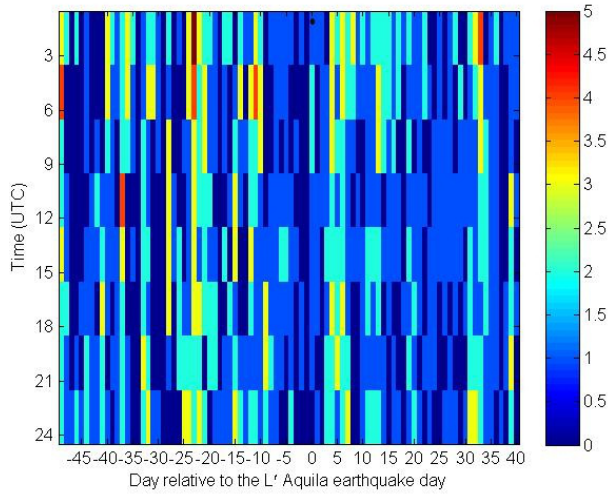
Fig.1. Changes of index in time interval corresponding to L’Aquila earthquake p K Fig. 1. Changes of K p index in time interval corresponding to L’Aquila earthquake.